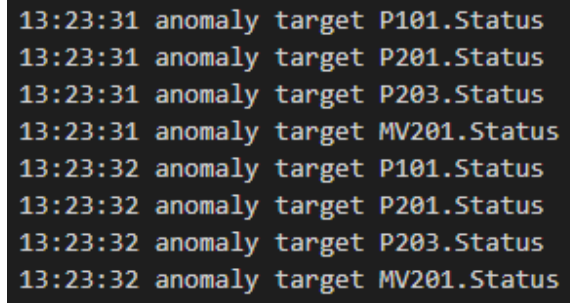
Figure 6. Alarms information of the multi-point attack.